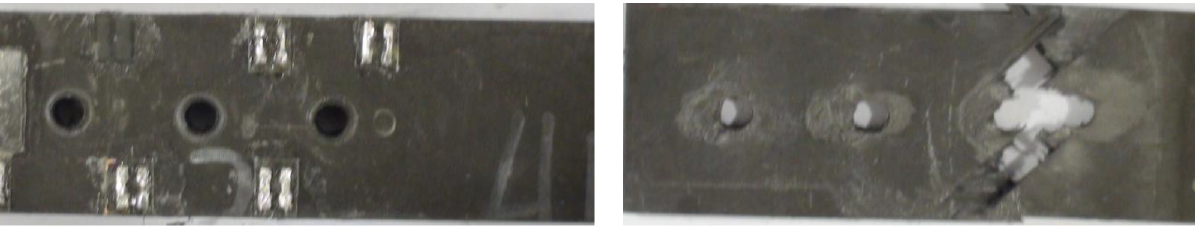
Figure 14. Experimentally observed failure of the bolted joint.